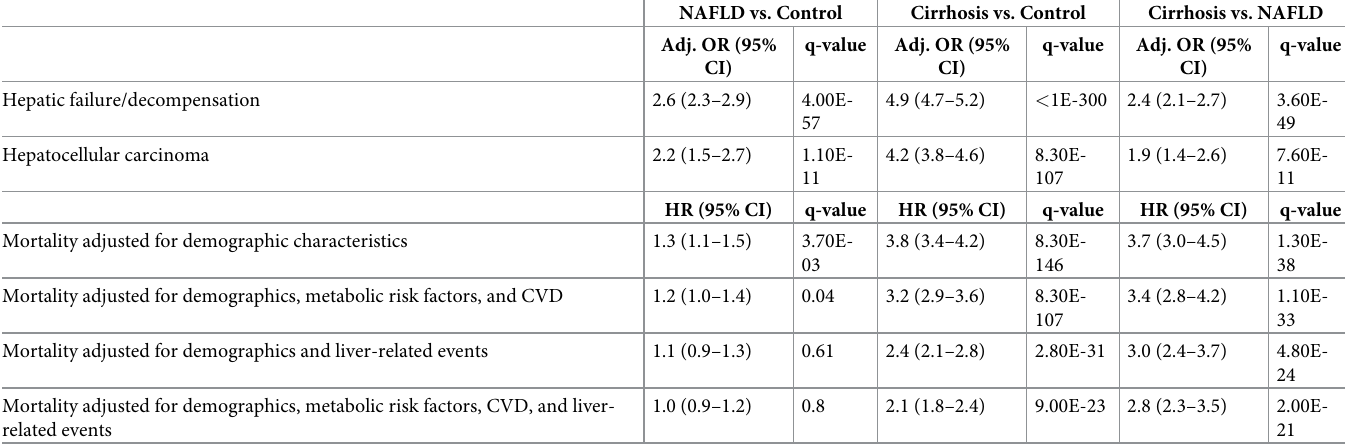
Table 3. Adjusted odds ratios for liver-related outcomes and adjusted mortality hazard ratios. NAFLD vs. Control Cirrhosis vs. Control Cirrhosis vs.